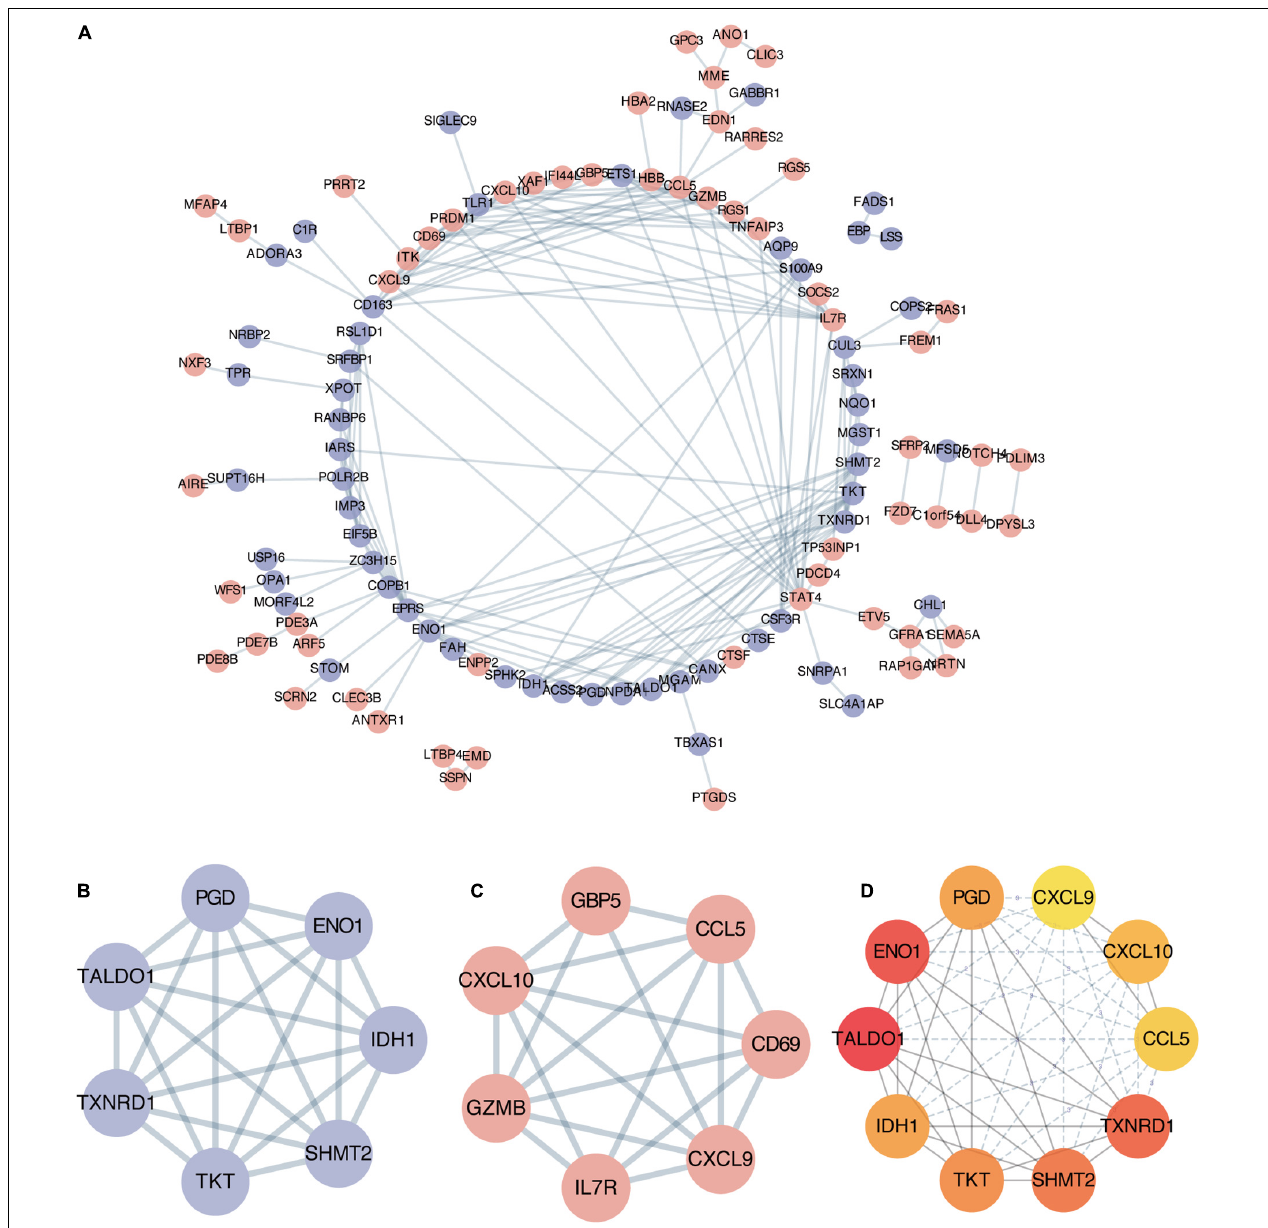
FIGURE 4 | Establishment of protein-protein interaction (PPI) network and hub genes identification. (A) Entire PPI network of robust DEGs. The red nodes represent upregulated DEGs and the purple nodes represent downregulated DEGs. (B) The significant module 1 identified from PPI network via MCODE (score = 7). (C) The significant module 2 identified from PPI network via MCODE (score = 6.3). (D) The top 10 hub genes with highest degrees identified by cytoHubba analysis, the shade of red color represents the degree of